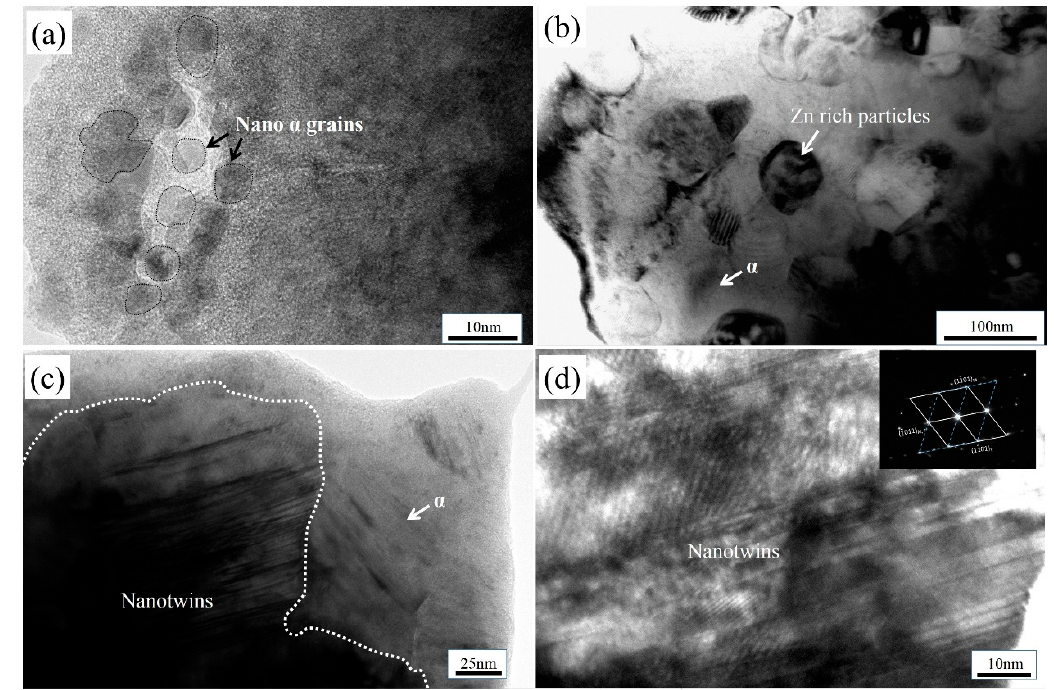
Figure 6. TEM images of TC4/Zn composite in the upper surface: ( a ) Nano α grains, ( b ) Zn rich particles, ( c ) Nano α twins, and ( d ) highly magnified image of nanotwins in Figure 6c and the inset showing the SAED pattern of the nanotwins.